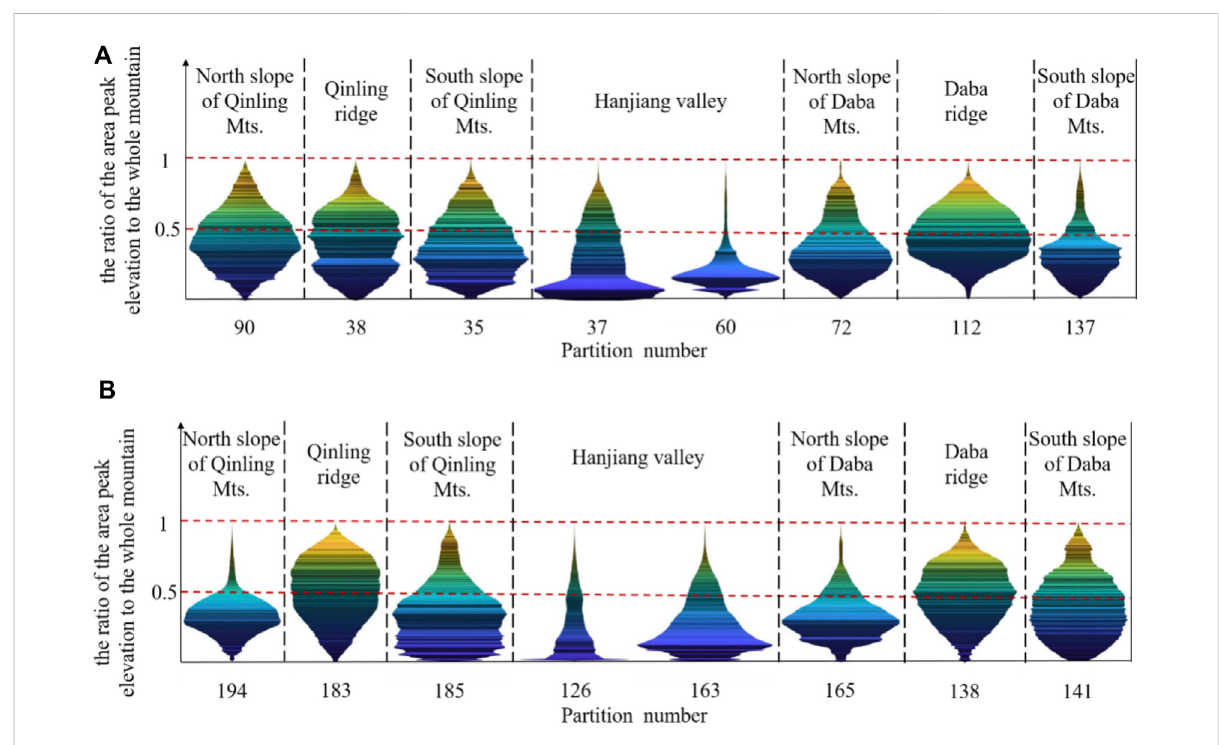
FIGURE 11 Mountain structure recognitions near 107.81 ° E (A) and 110.53 ° E (B) in the QDM.